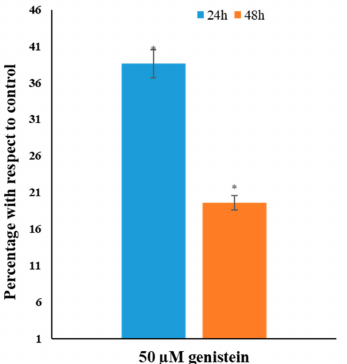
Figure 4. E ff ect of genistein on global DNA methylation in HeLa cells. Genistein (50 µ M) significantly decrease the levels of global DNA methylation in HeLa cells in a time dependent manner. The decrease is methylation level is represented as a percentage of the untreated control. Values are means ± SD of three independent experiments (* p ≤ 0.05).